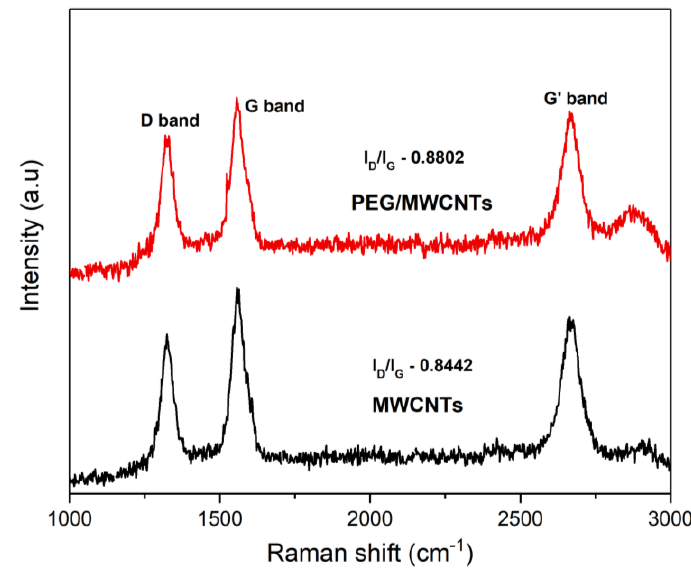
Figure 5. Raman spectra of MWCNTs and PEG/MWCNTs on silicon dioxide recorded from 1000 to 3000 cm − 1 with calculated I D /I G ratios. Table 1. The atomic composition of the short MWCNTs.